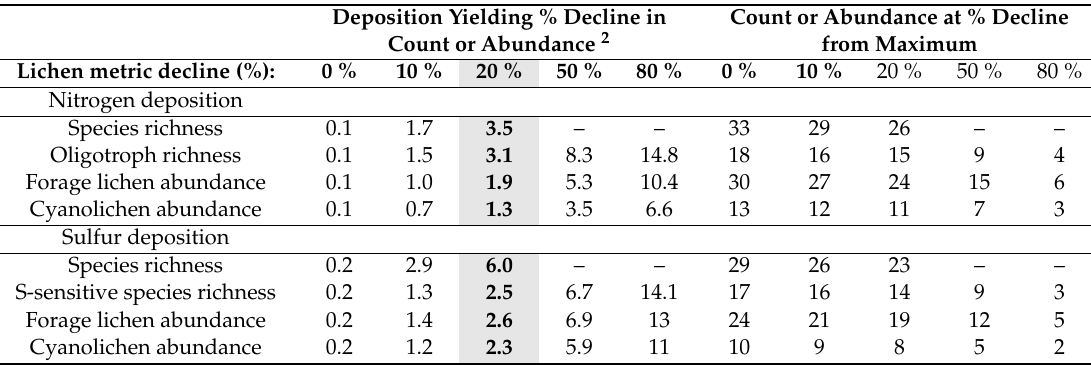
1 Models used to assess risk. 2 Models used to explore the behavior of the metric under variable (instead of optimized) climate. Table 3. Risks to lichen diversity and abundance, tabulated as the percent change in the 90% quantiles of lichen metrics associated with various levels of deposition, and recommended critical loads 1 (grey shading). Recommended risk categories: Low = < 20% decline in a metric, moderate = > 20–50%, high = > 50–80%, and very high = > 80% declines. – = insu ffi cient data to